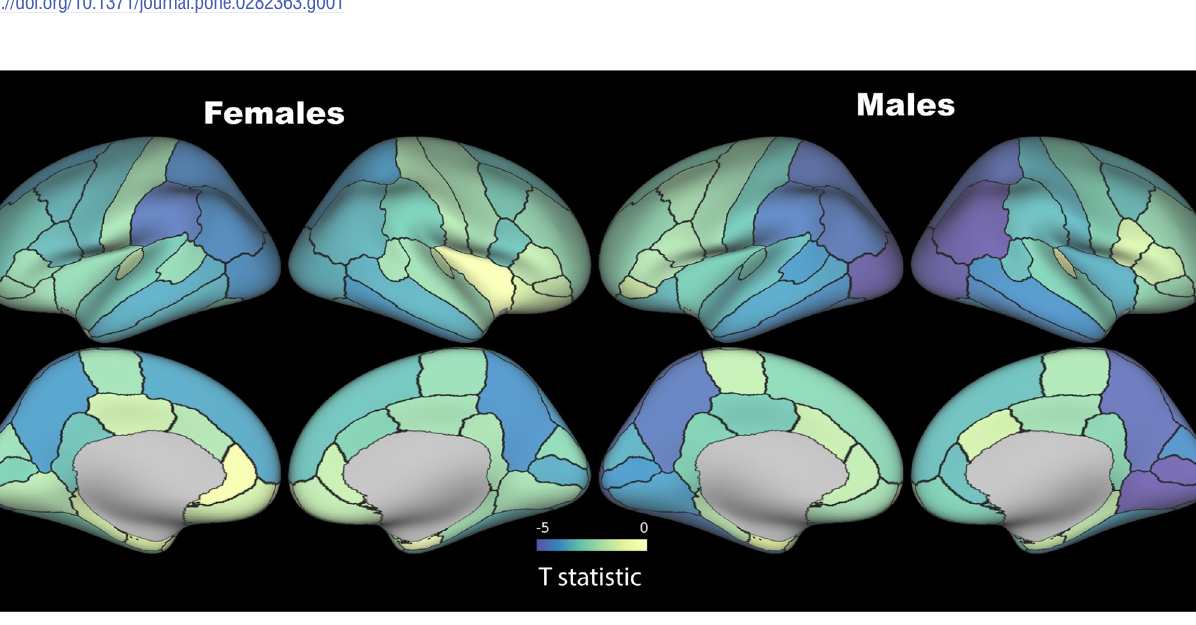
PLOS ONE | https://doi.org/10.1371/journal.pone.0282363 March 22,